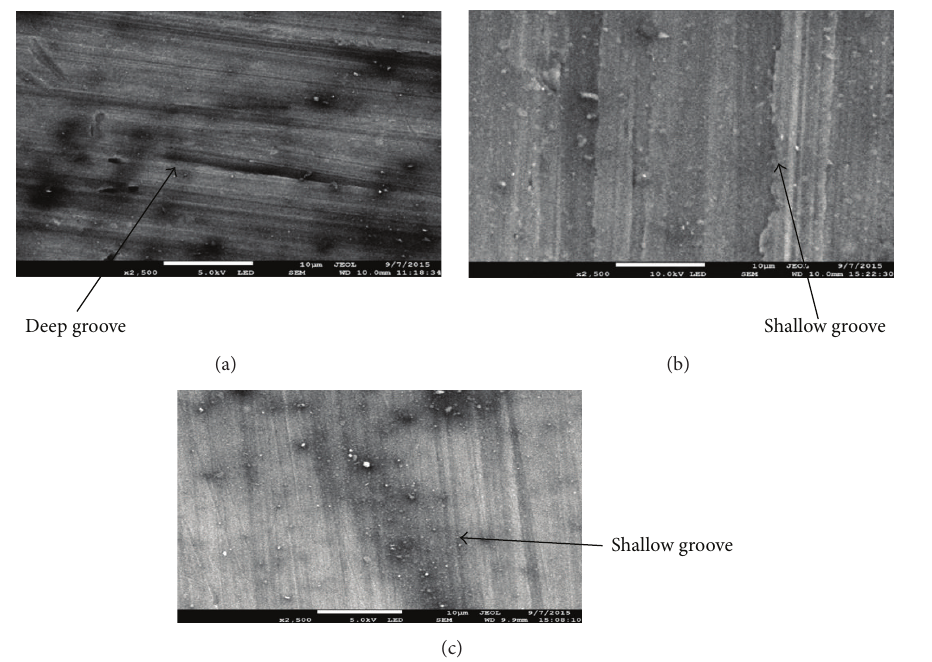
Figure 10: SEM images of the surface of aluminum plate for different volume concentrations of biolubricant; (a) 10% waste oil; (b) SAE 40; and (c) 5% waste